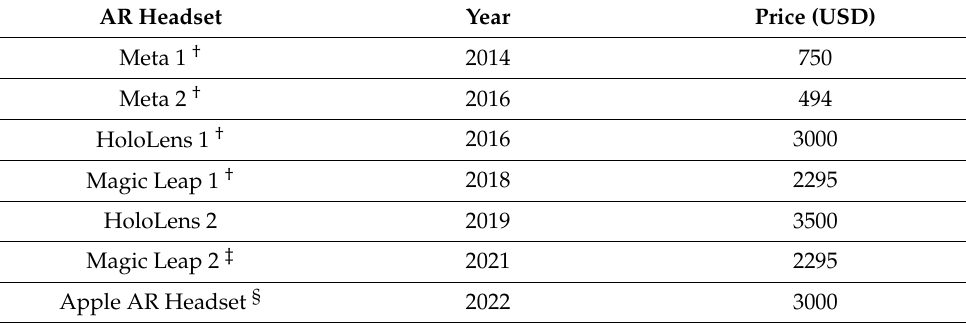
Table 2. This table shows the modern AR HMDs commercialized over the last decade and the retail prices associated with the devices. ( † Discontinued, ‡ planned, and §